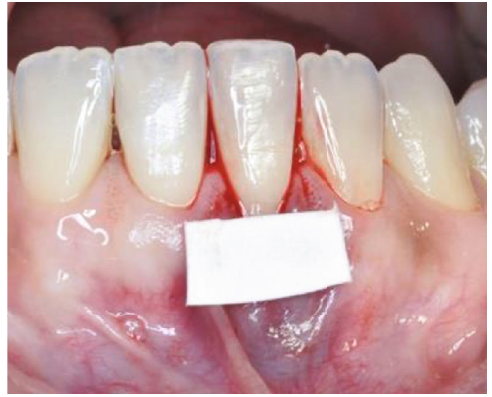
Figure 6: Surgical map with sterilized paper.